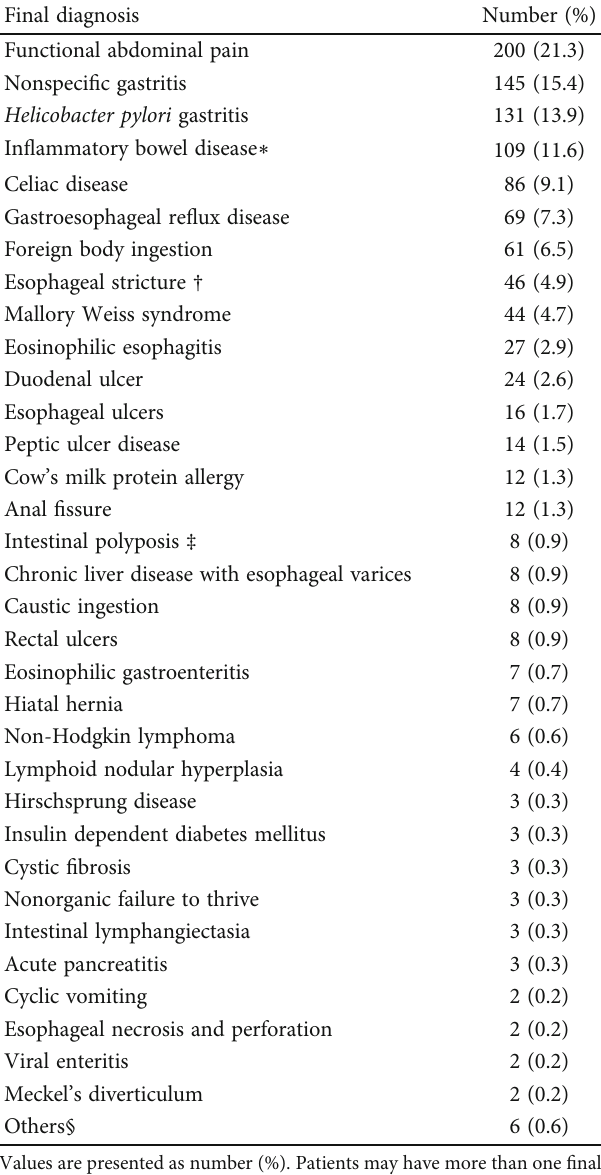
Table 4: Final diagnosis of children who underwent gastrointestinal endoscopy ( n = 941